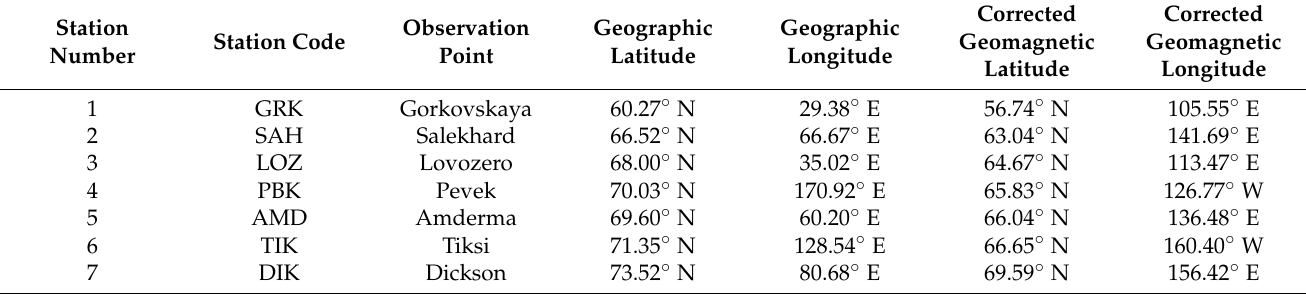
Table 2. Geographic and corrected geomagnetic coordinates of high-latitude ionosphere vertical sounding stations.